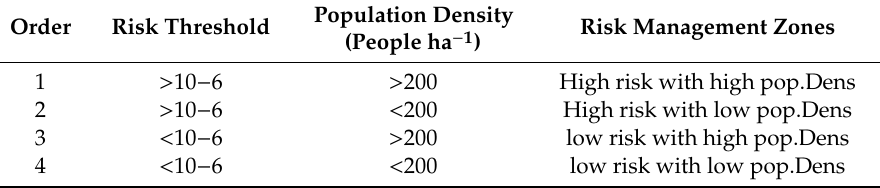
Table 3. Risk zoning matrix combining risk threshold and population